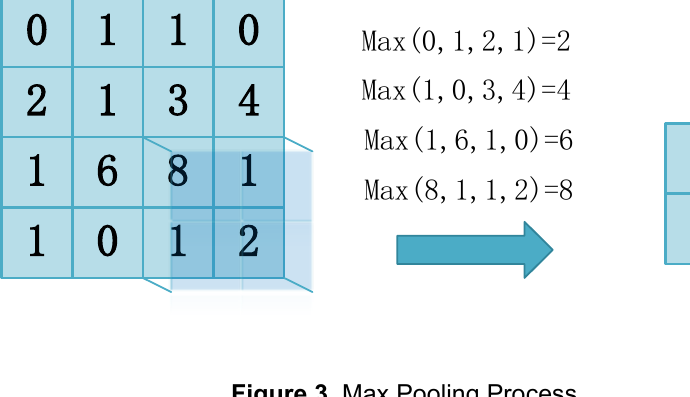
Figure 3. Max Pooling Process